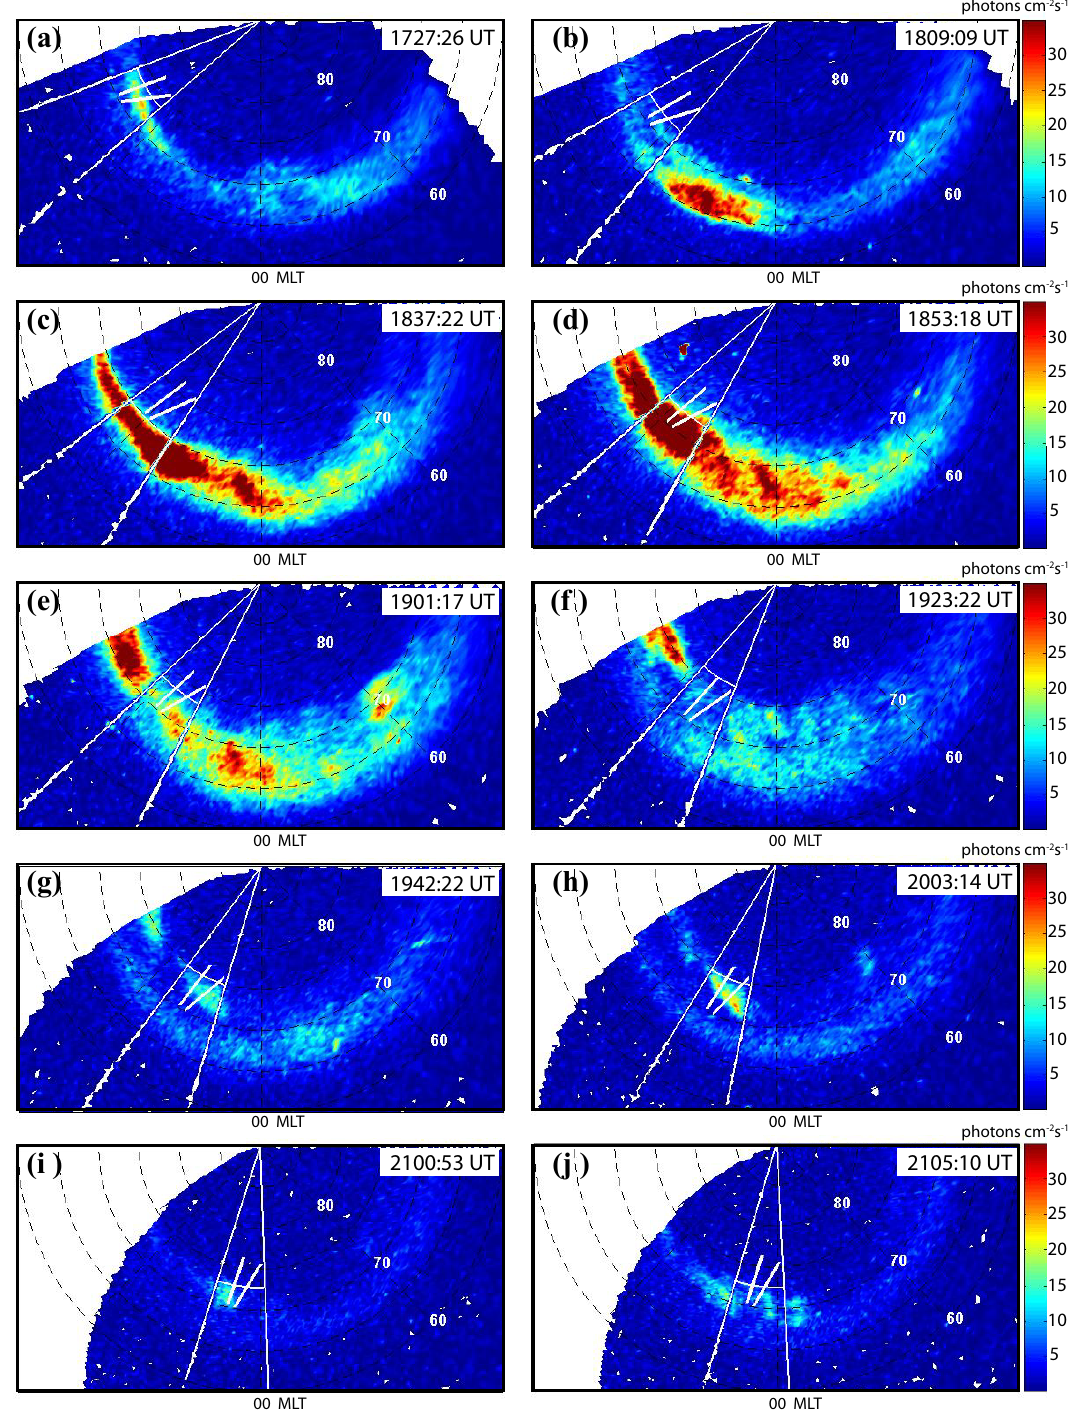
Fig. 7. Selected set of Polar UVI frames showing the general substorm evolution on 25 November 2000. The PAE boundary is marked by a white arc connecting the EISCAT MLT sector boundaries. Two straight white lines in the sector indicate the EISCAT VHF radar beams. See details in the